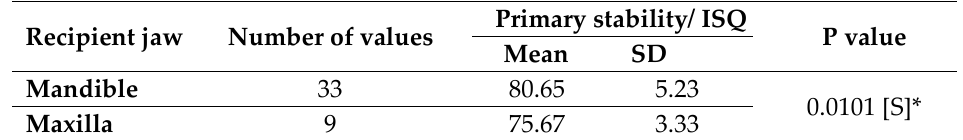
Table (1): The differences of the primary stability ISQ value in relation to the recipient jaw.